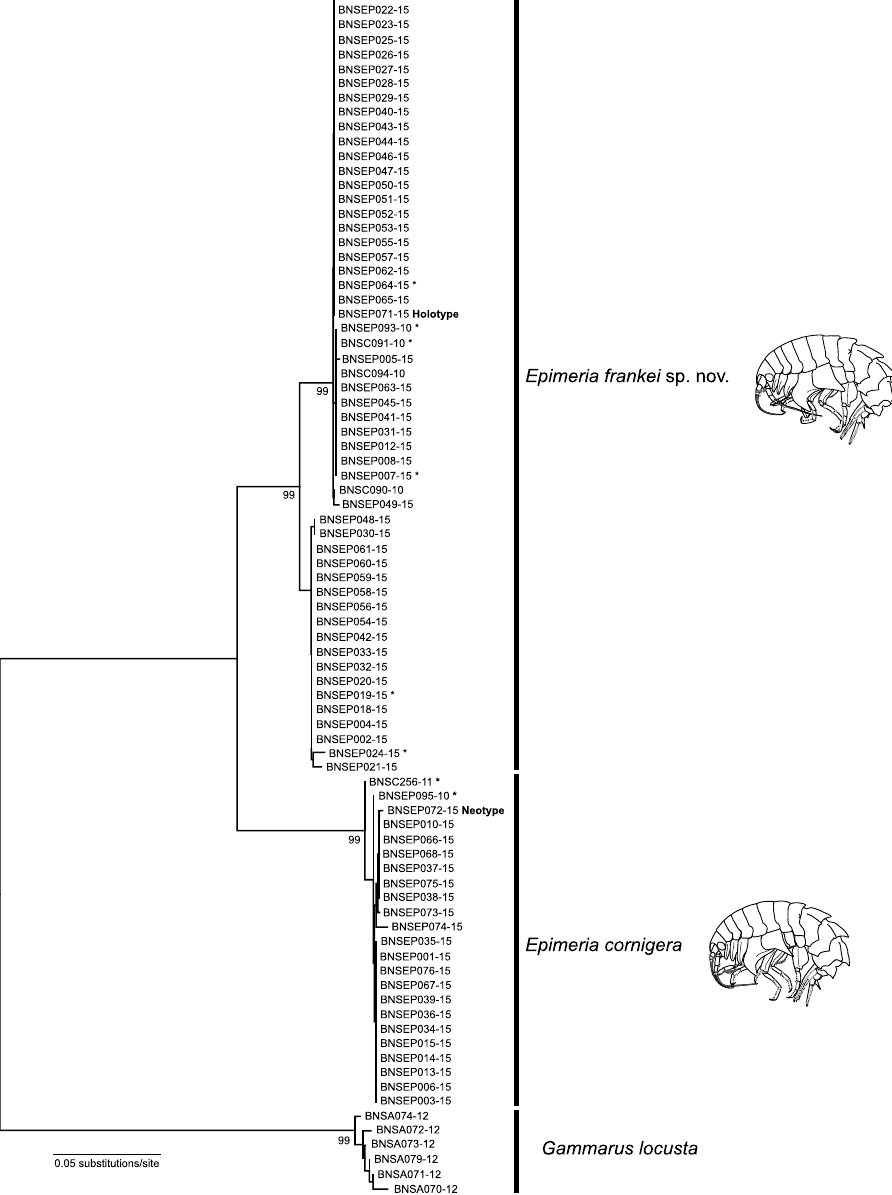
Figure 1. Neighbor-joining phylogenetic tree of the analysed COI sequences of Epimeria cornigera , Epimeria frankei sp. nov., and Gammarus locusta as outgroup. The optimal tree with the sum of branch length = 0.44256318 is shown. Evolutionary distances were computed using the Kimura 2-parameter model for substitution. Numbers next to internal branches are non-parametric bootstrap values (in %). Only values above 90% are shown. Asterisks indicate specimens with additional complete 18S rRNA gene sequence data. All codon positions were included. All ambiguous positions were removed for each sequence pair. There were a total of 658 positions in the final